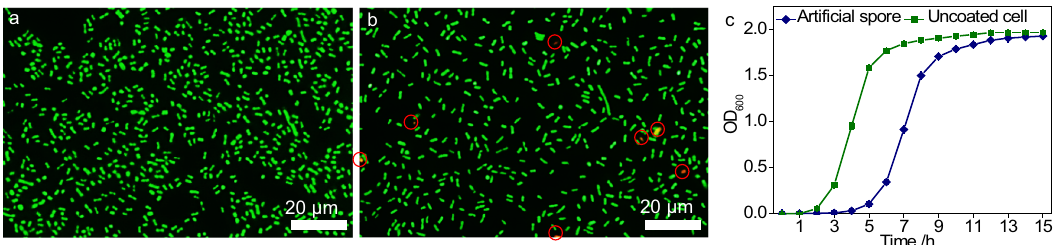
Fig. 3 Evaluation of the biocompatibility of the sporulation process. Live/dead assay for ( a ) native E. coli cells and ( b ) arti fi cial spores; green - live cells; red - dead cells. c Growth curve of native E. coli cells (green curve) and arti fi cial spores (blue curve). The results in ( c ) are the average values of three parallel experiments. The error bars represent the standard deviations of three parallel measurements, n = 3.